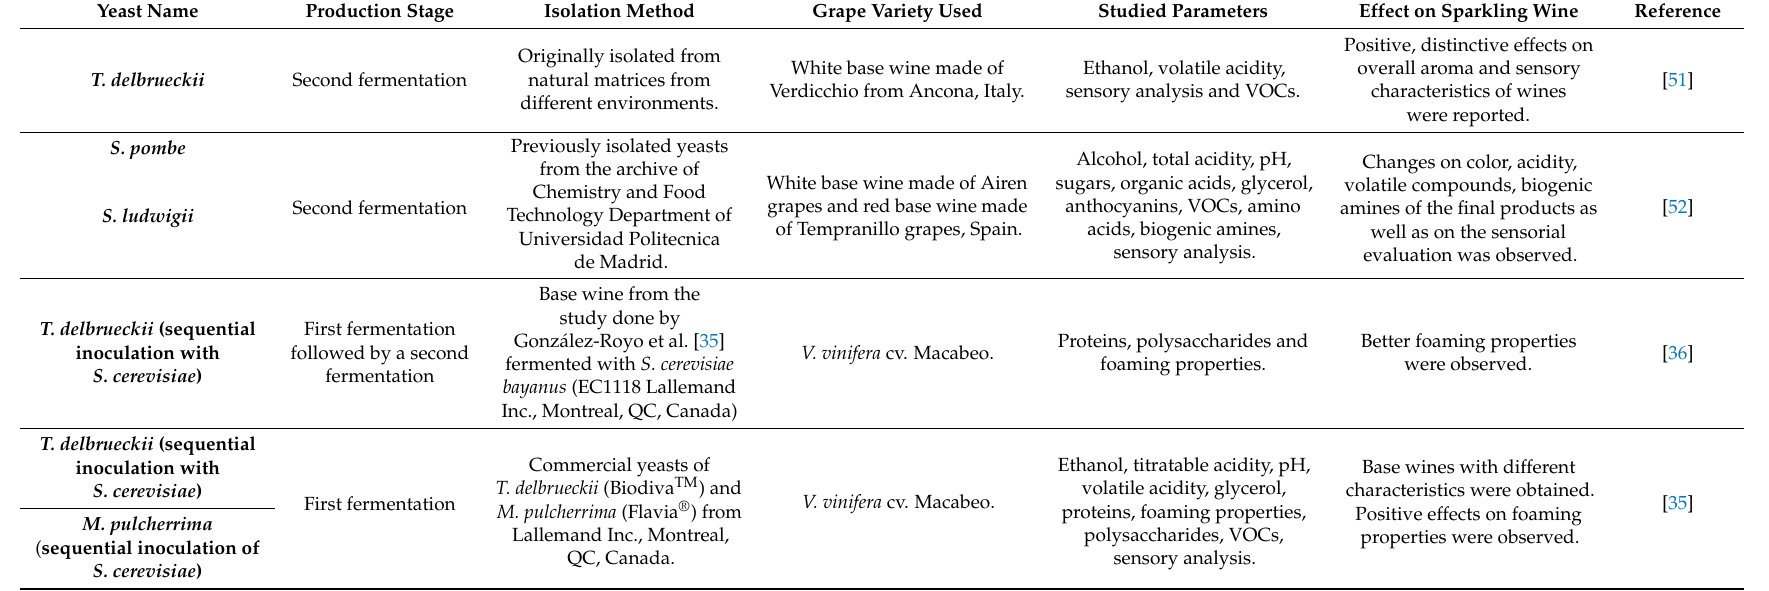
Table 1. Effects of non- Saccharomyces yeasts studied in base wines and sparkling